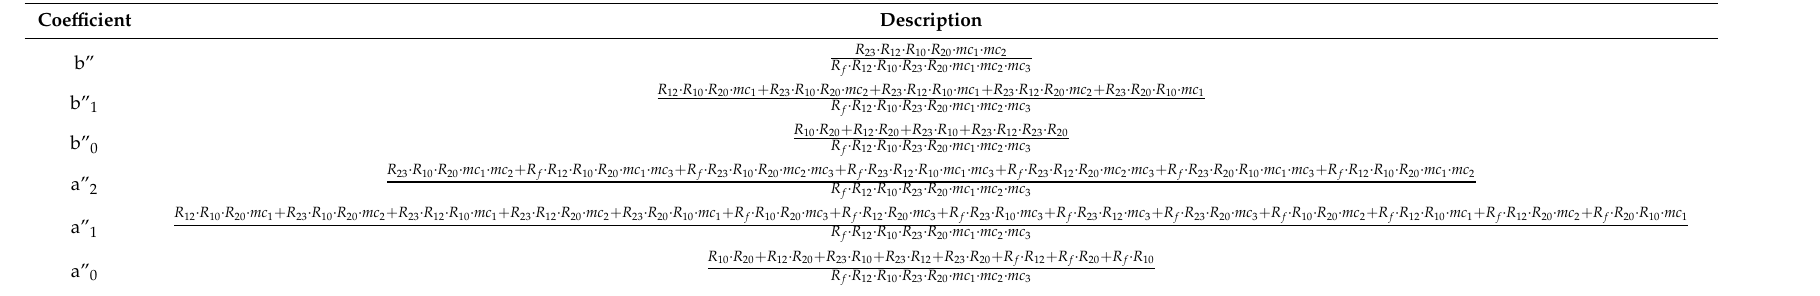
b (cid:48)(cid:48) s 2 + b (cid:48)(cid:48) s + b (cid:48)(cid:48) 2 0 1 s 3 + a (cid:48)(cid:48) s 2 + a (cid:48)(cid:48) s + a (cid:48)(cid:48) 2 0 1